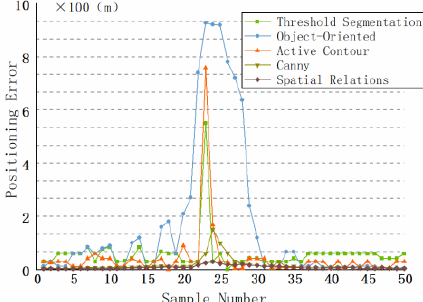
Figure 11. Error distribution of the five methods for waterline positioning